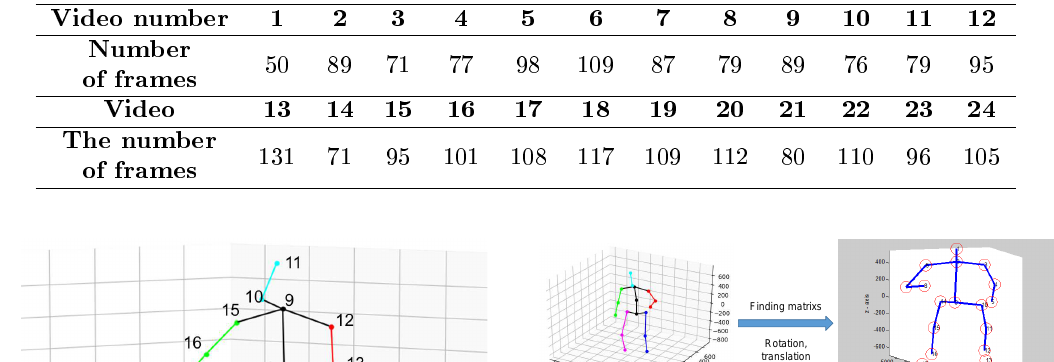
Tab. 4: Number of frames in martial arts postures of VNMA database.